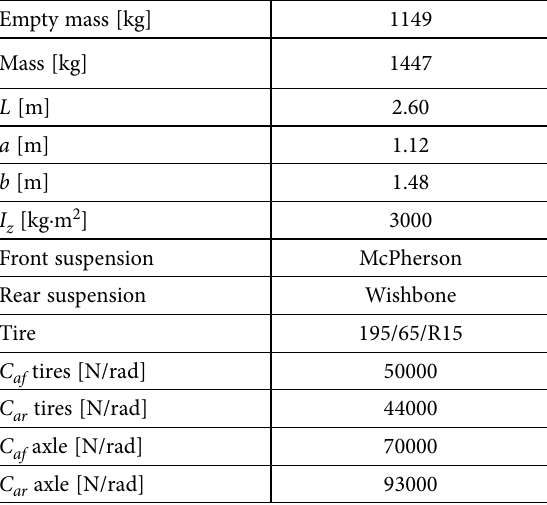
Table 4. Test vehicle